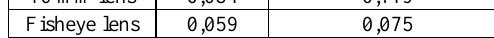
Table 9. Statistical values of set of distances for ceiling.